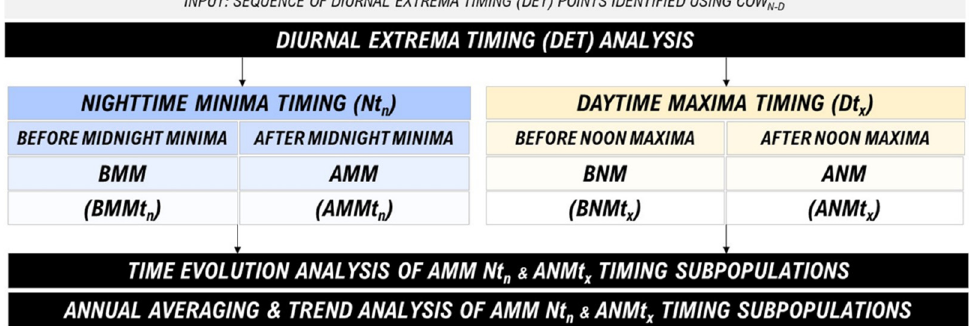
Figure 5. The approach for the DET analysis is based on the COW N–D extrema sequence.